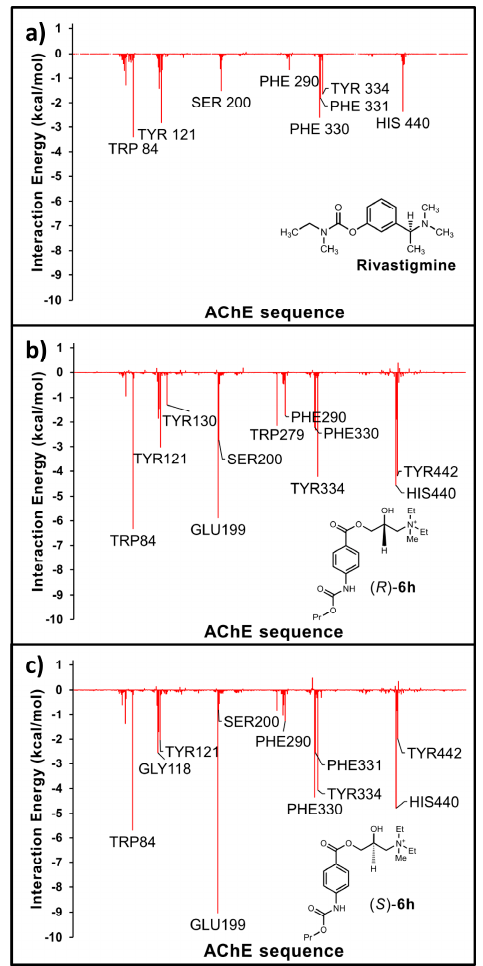
Figure 1. Histograms of interaction energies partitioned with respect to the AChE, amino acids in complex with ( a ) rivastigmine; ( b ) ( R )- 6h and ( c ) ( S )- 6h . The X -axis denotes the residue number of AChE, and the Y -axis denotes the interaction energy between the compounds and specific residue. Negative values and positive values are favorable or unfavorable to binding, respectively.